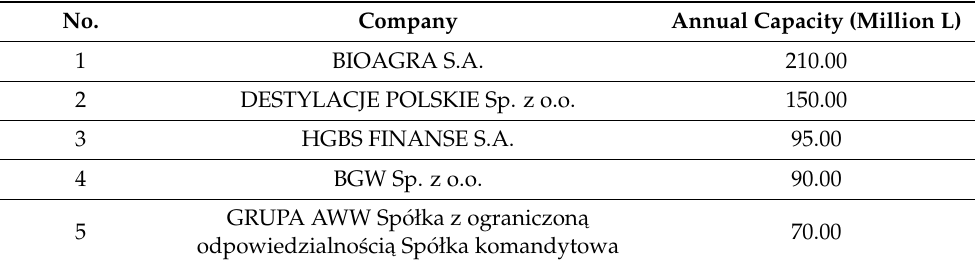
Table 6. Manufacturers and annual capacity of bioethanol production installations in Poland